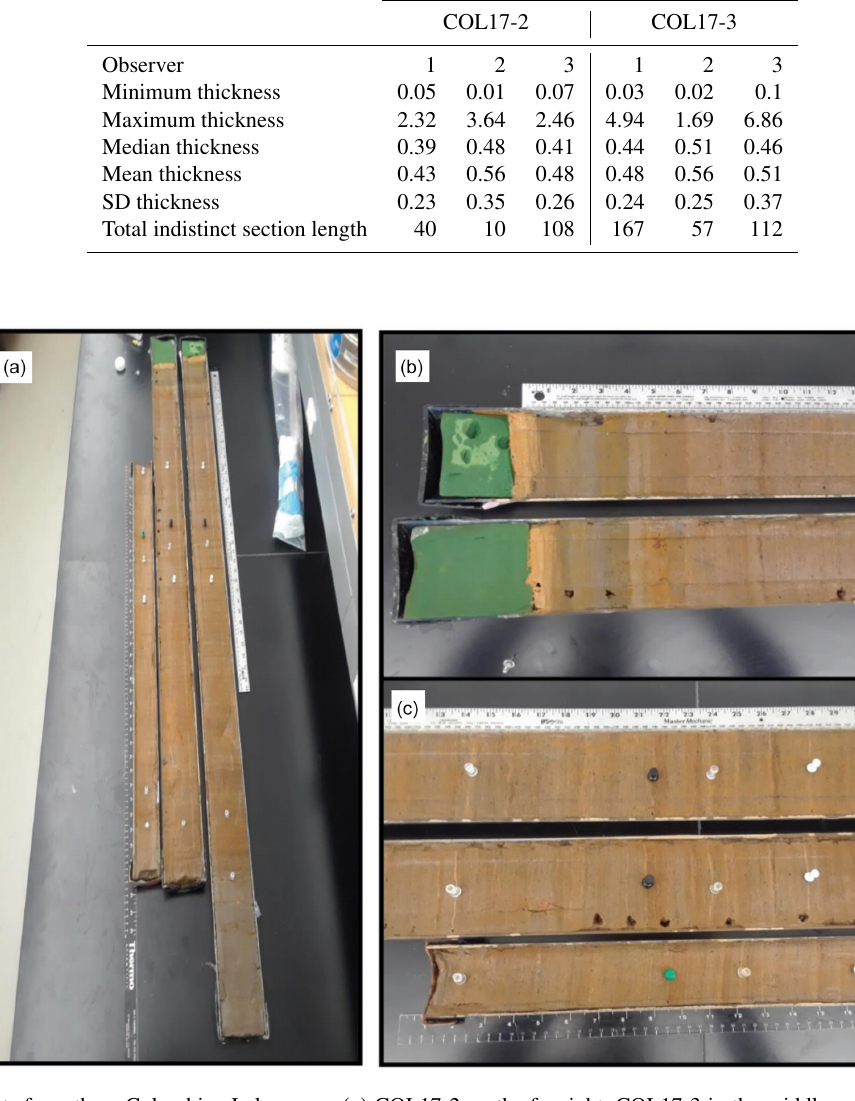
Figure A1. Tie points from three Columbine Lake cores. (a) COL17-2 on the far right, COL17-3 in the middle, and COL16-1 on the left. The top of cores COL-17-3 and COL17-2 are shown in (b) . Panel (c) is a section of the middle of all three cores with matching laminations marked with pins. Image credit: C. Wiman (2019). Late Holocene hydroclimate and productivity in varved sediment at Columbine Lake, Colorado (Master thesis, Northern Arizona